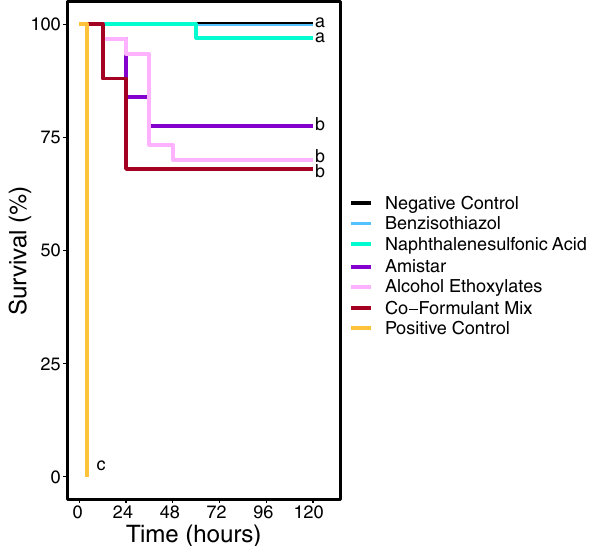
Figure 1. A Kaplan–Meier plot showing survival against time; colour coded by treatment. The negative control and benzisothiazol line is split to allow both to be visible, as both treatments had 0% mortality. Different letters indicate statistically significant